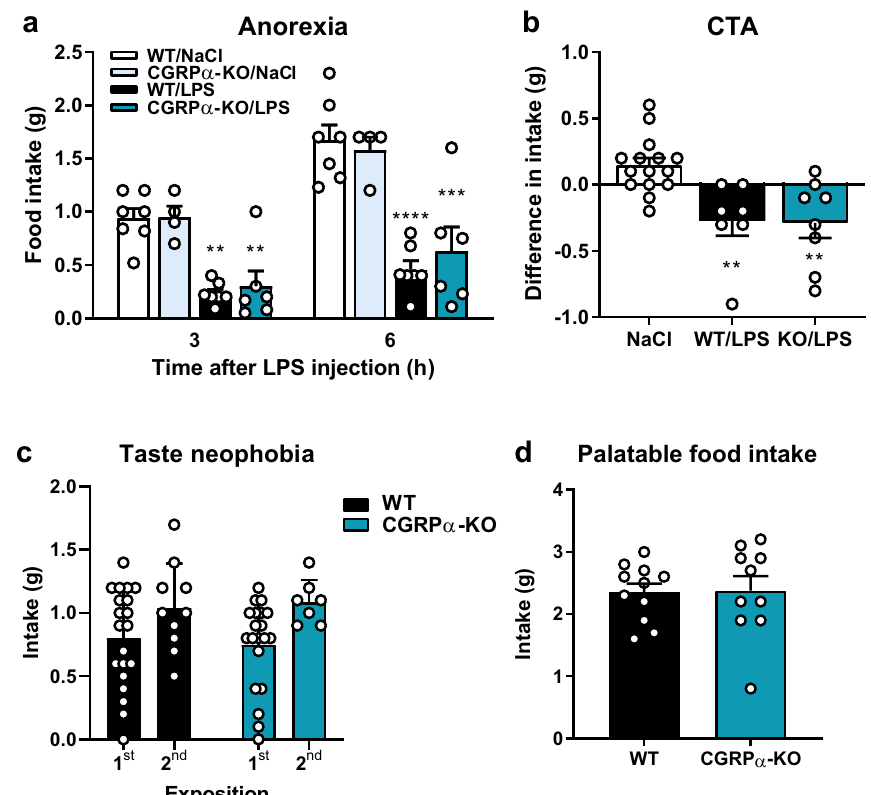
Figure 3. Food consumption in αCGRP-KO mice. ( a ) Inflammation-induced anorexia was similar in αCGRP-KO and WT animals. Two-way ANOVA followed by Holm–Sidak’s multiple comparisons test: 3 h: treatment: F (1,20) = 35.51, p < 0.0001; genotype: F (1,20) = 0.0055; p = 0.82; interaction: F (1,20) = 0.11; p = 0,74. 6 h: treatment: